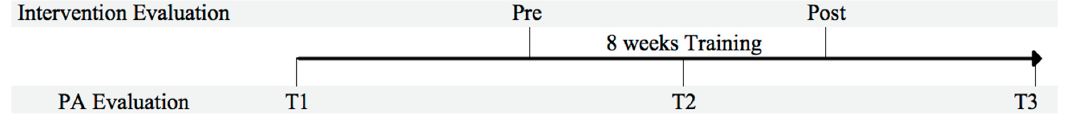
Figure 1. Assessment timeline; PA (Physical activity) evaluation; T1: Evaluation before the training; T2: Evaluation during training T3: Evaluation after training.